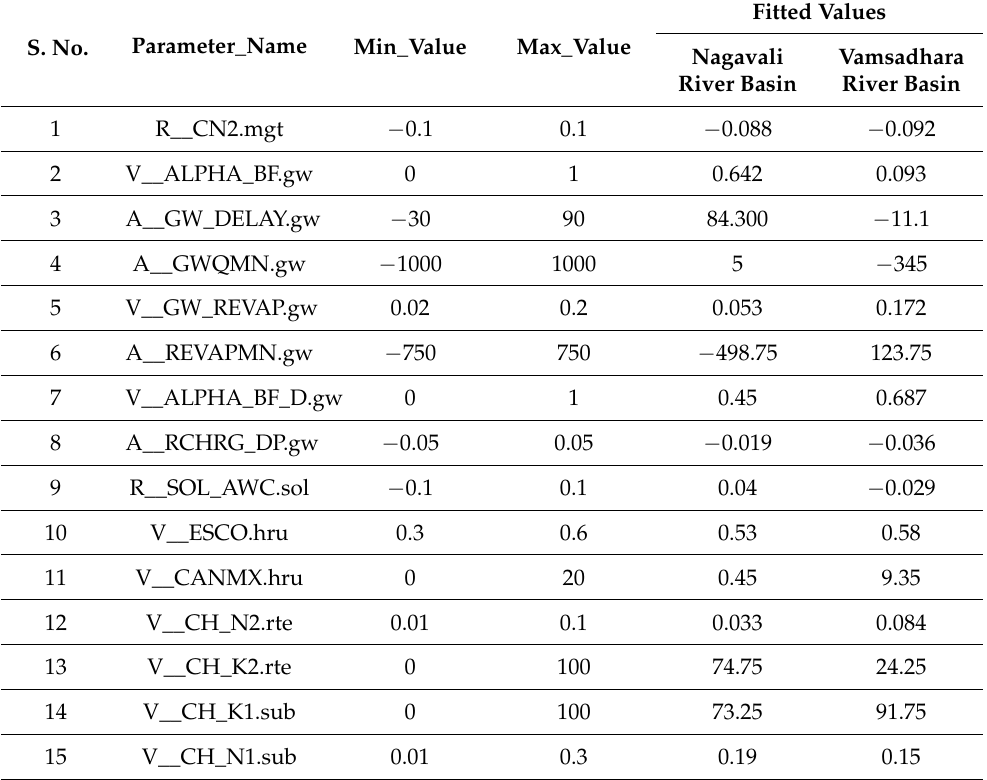
Table 4. Calibrated parameters and their fitted values for streamflow simulations.